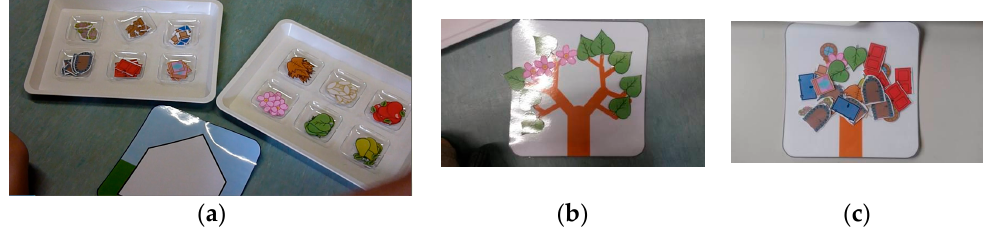
Figure 2. ( a ) The ICT materials; ( b ) Congruent; ( c ) Mixed.